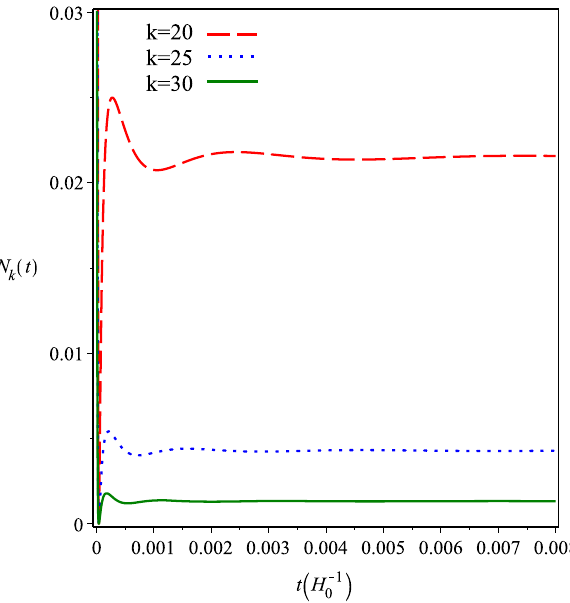
− 1 . To establish 0